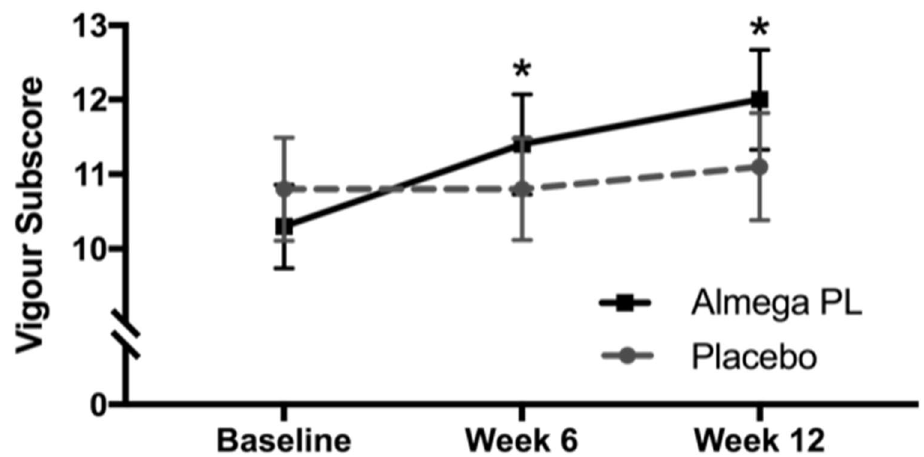
Figure 4. Profile of Mood States (POMS), subscore for Vigour for both the Almega ® PL group and the placebo group. Values represented as mean ± SEM, *change from baseline significantly different to placebo, p < 0.05.